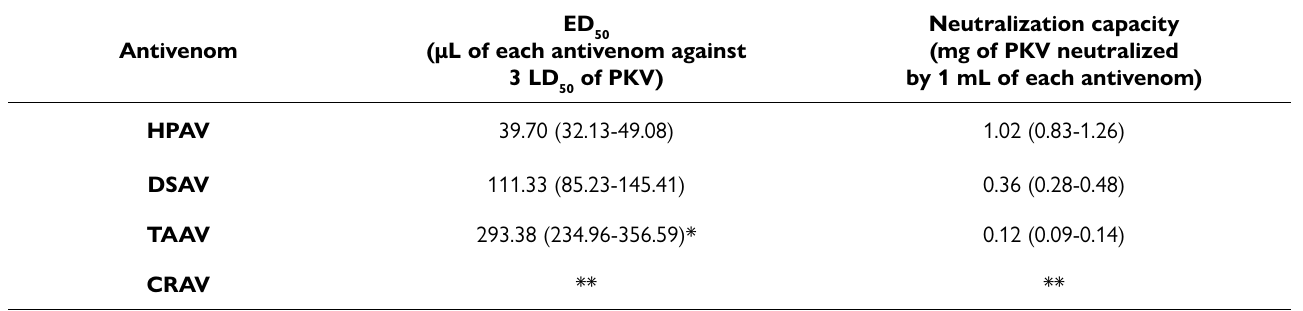
) and neutralization capacities (ER 50